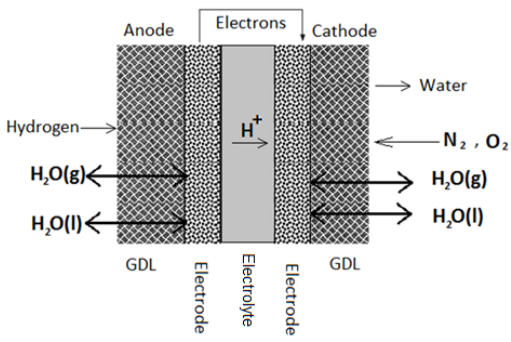
Figure 1. Membrane Electrode Assembly.